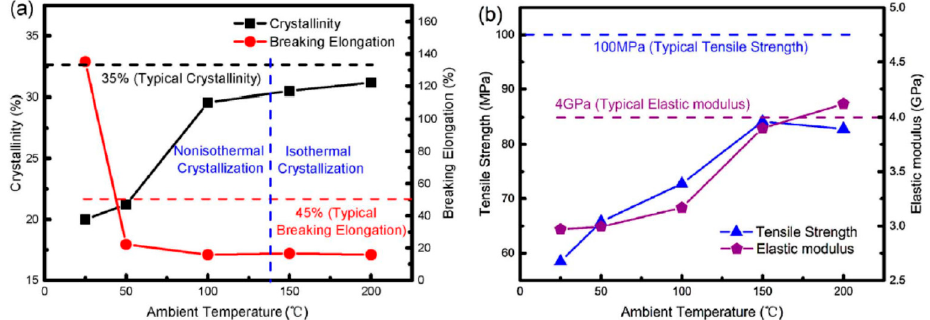
Figure 9. Ambient temperature dependency of ( a ) crystallinity and ( b ) mechanical properties of PEEK samples [88].